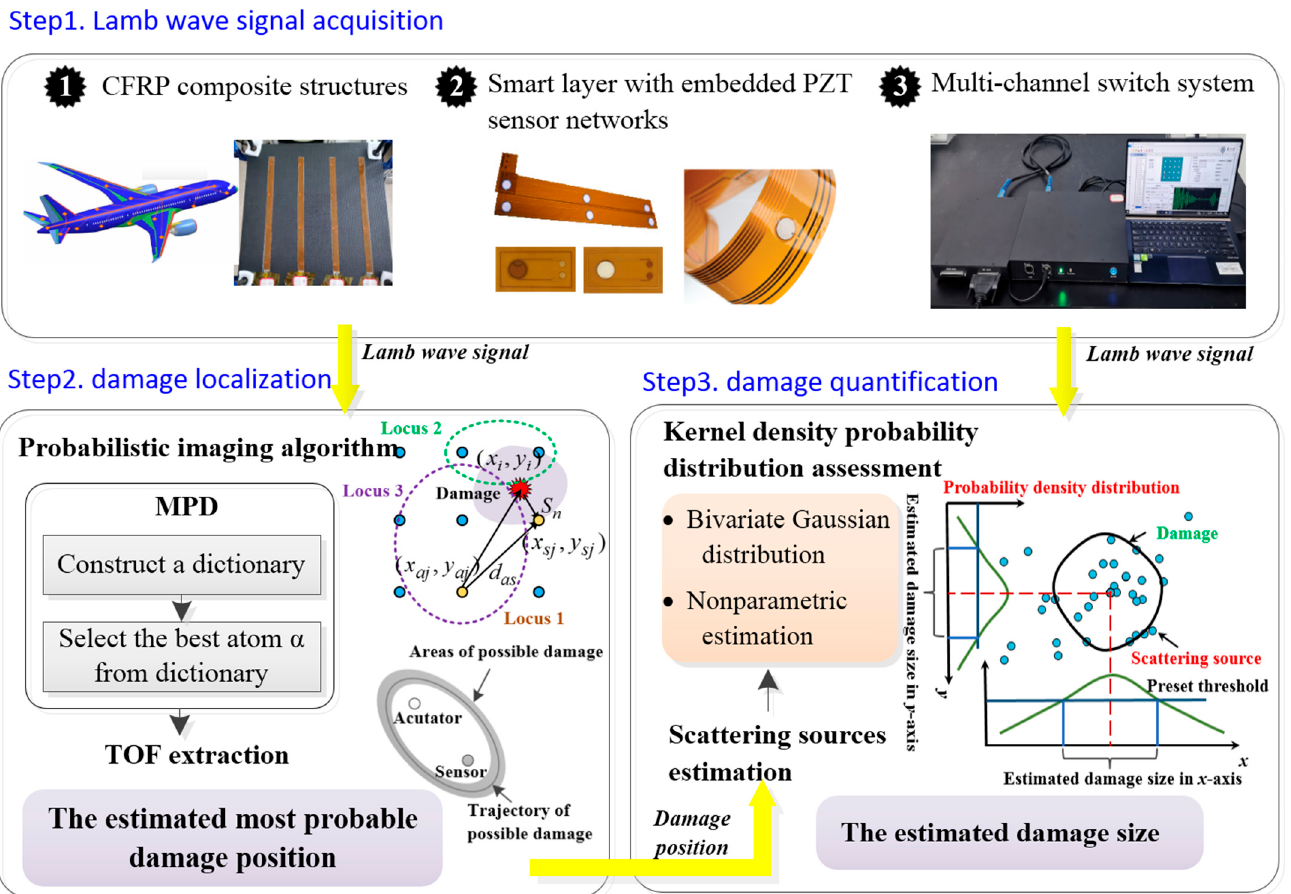
Figure 1. The flowchart of the experiment .